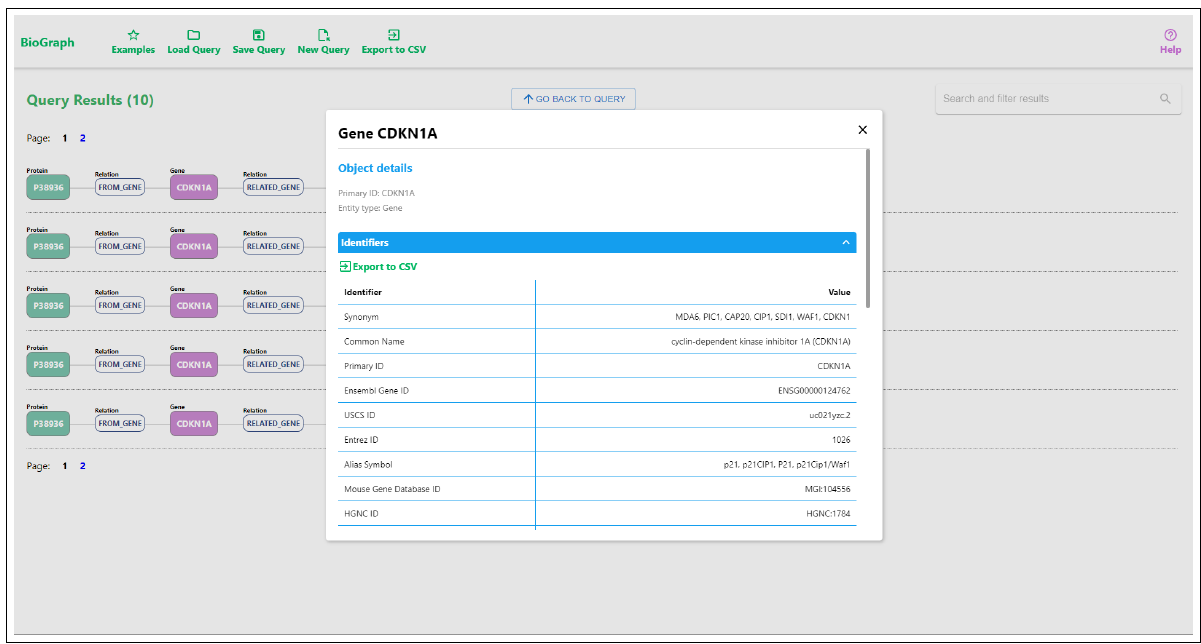
Figure 8. Details of a single gene entity, displaying information collected from multiple data